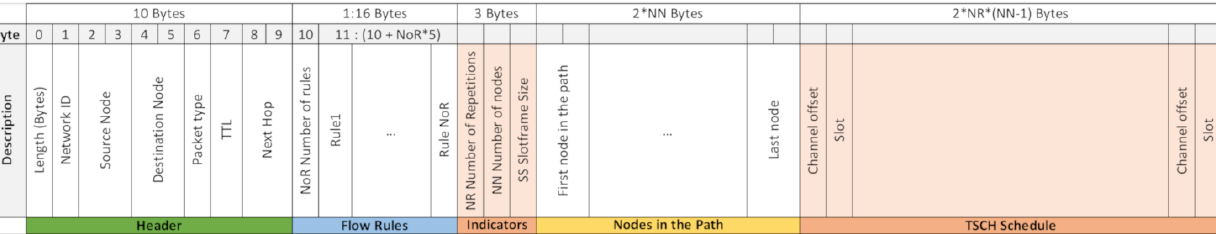
Figure 5. Structure of the OpenPathTSCH packet. Generic